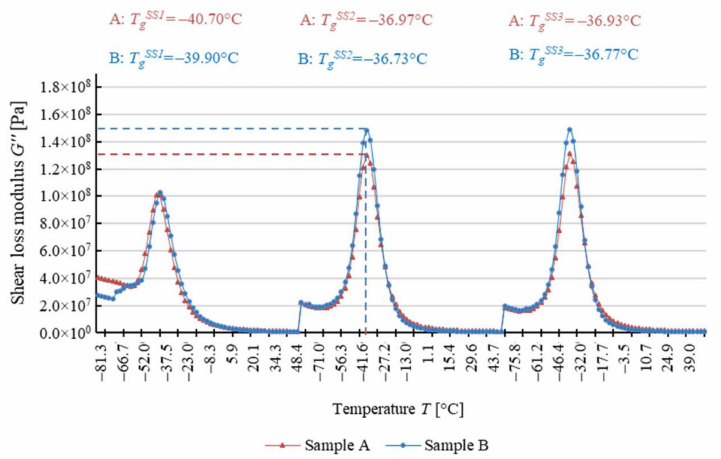
Figure 9. Determination of polyurethane glass transition temperature based on the shear loss modulus G (cid:48)(cid:48)